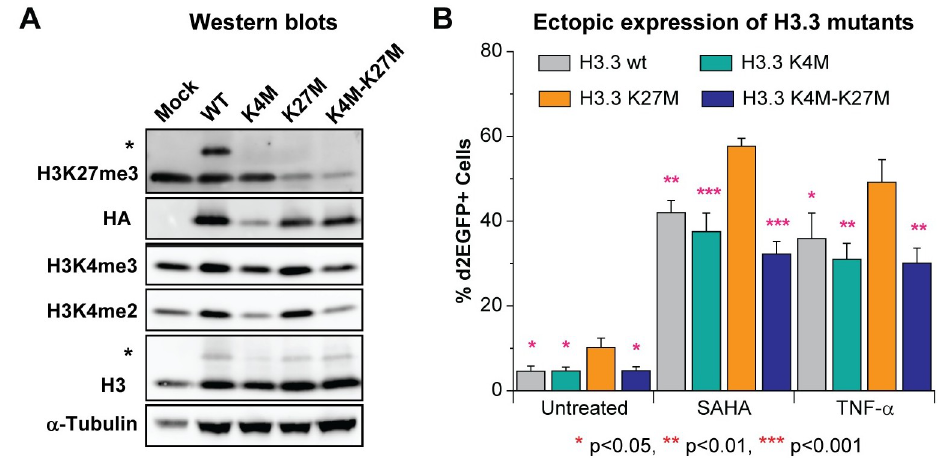
Fig 4. H3K4 methylation is crucial for HIV-1 reactivation mediated by H3K27 removal. (A) Western blot measuring the indicated histone H3 methylation levels of cells expressing HA tagged wild type (wt) H3.3 or indicated mutants of H3.3. The upper bands (marked with � ) from blots with antibodies against H3K27me3 and H3 are from the H3.3-HA variants. (B) Quantification of HIV-1 reactivation in E4 cells expressing wt H3.3 or indicated H3.3 mutants. Presented statistical significance was based on comparisons with H3.3 K27M variant. One-way ANOVA, n = 5 p < 0.005, Bonferroni posttests, � p < 0.05, �� p < 0.01, ��� p < 0.001. Error bars: SEM of 5 different replications.